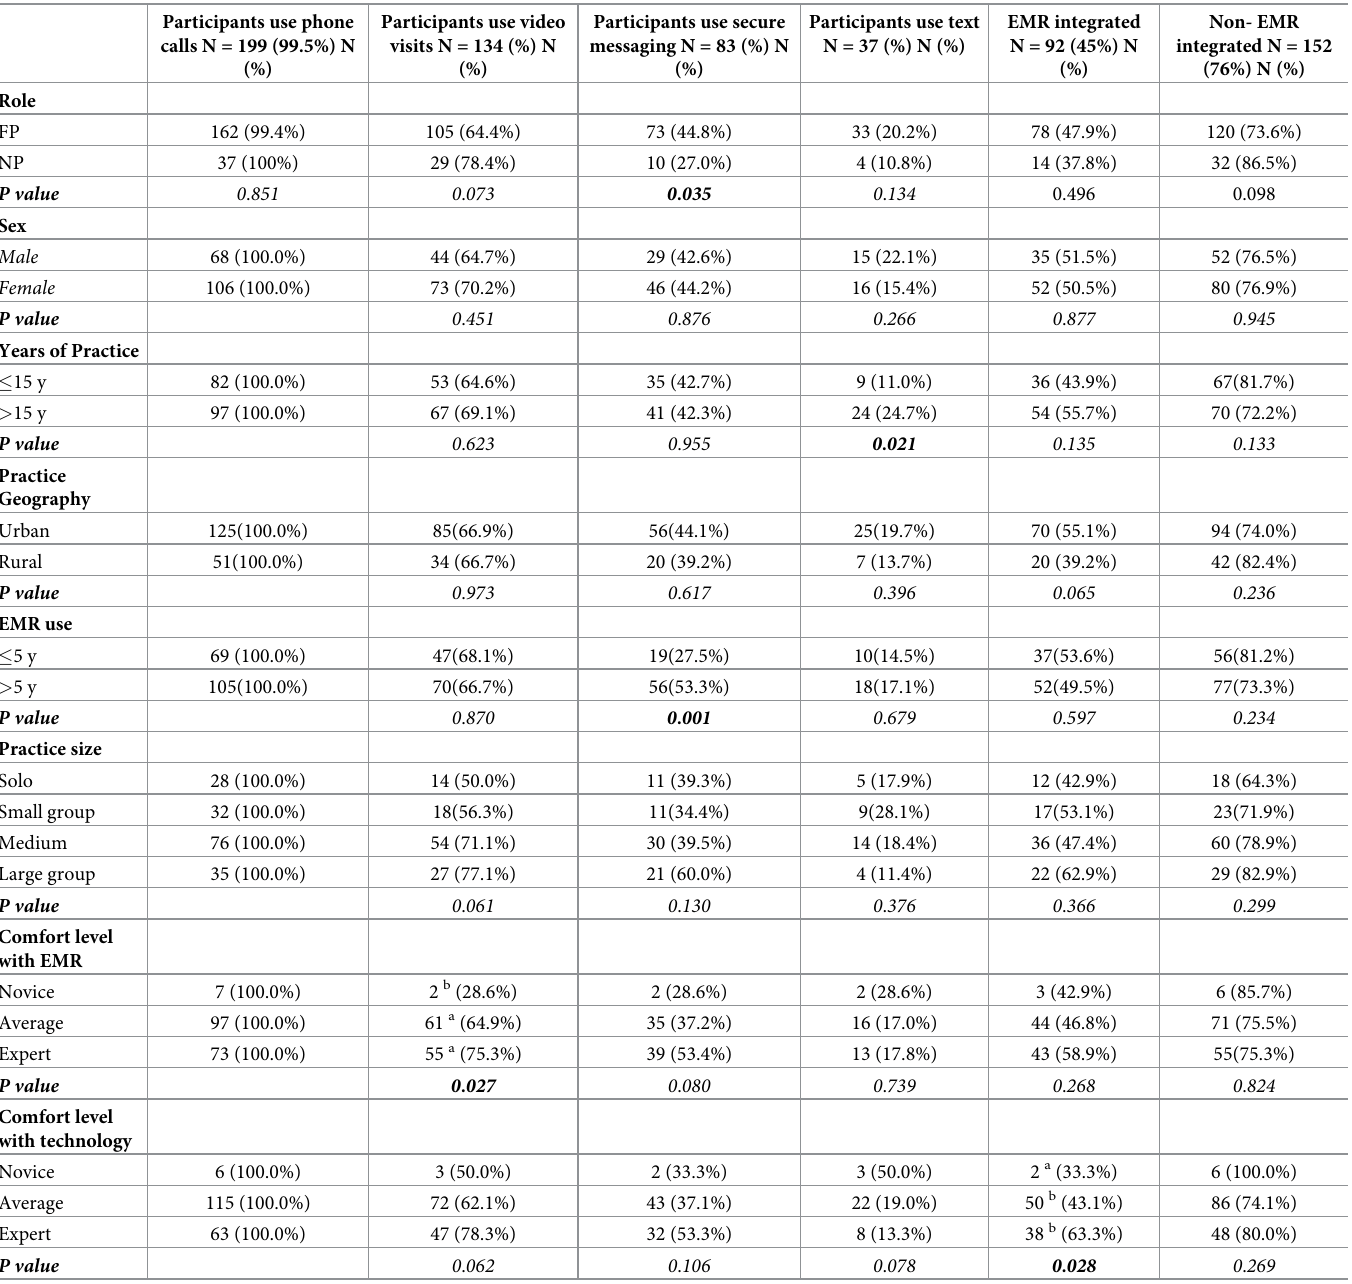
Table 2. Methods and platform use for virtual visits by respondents